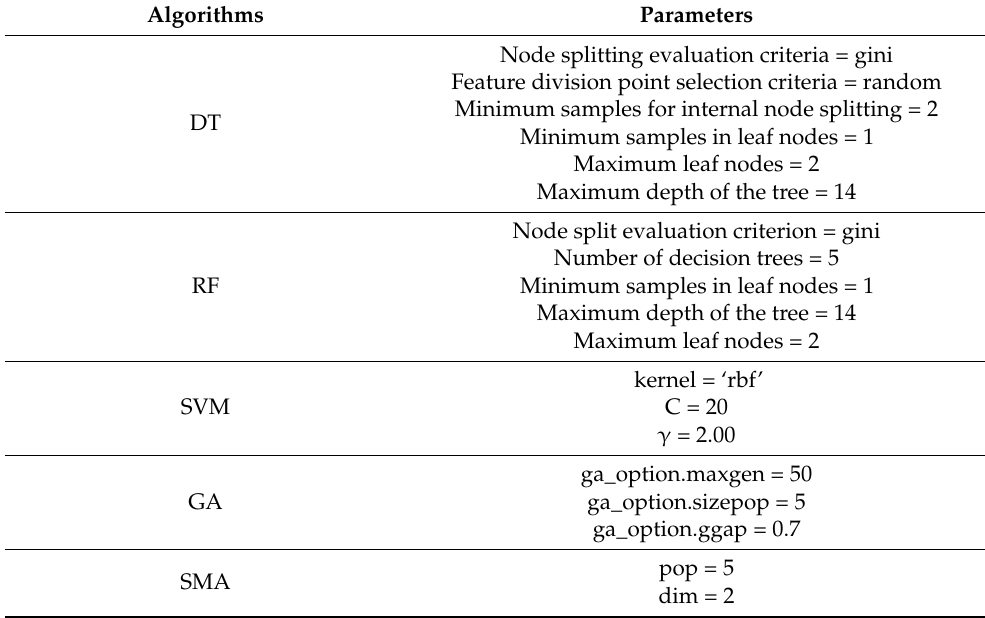
Table 2. Selected parameters of each algorithm.